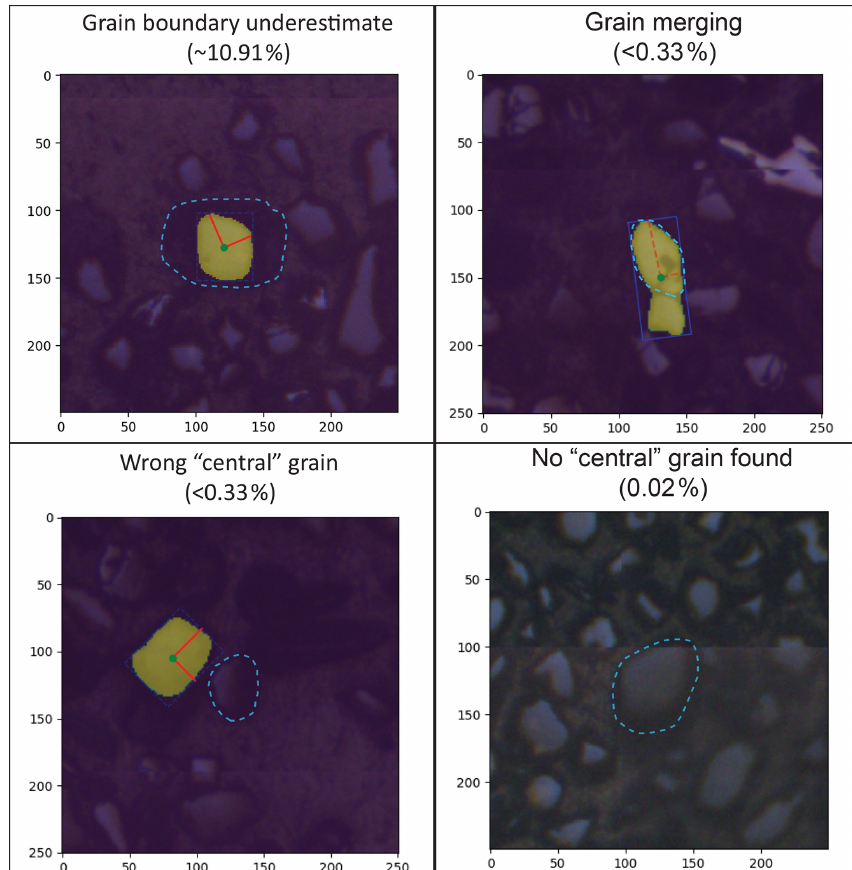
Figure 4. Examples of automated (M-ST-C) segmentation mask error modes with estimated occurrence rates, with axes scaled in microme- tres and correct grain segmentations outlined in light blue. Rates for “grain boundary underestimate” and “no central grain found” errors are estimated from analysis of the entire Leary et al. (2022) dataset (i.e. Table 2). No “grain merging” or “wrong central grain” errors were identified in a manual review of the n = 301 sample of the full dataset (i.e. Table 2), and their occurrence rates are estimated from their non-appearance